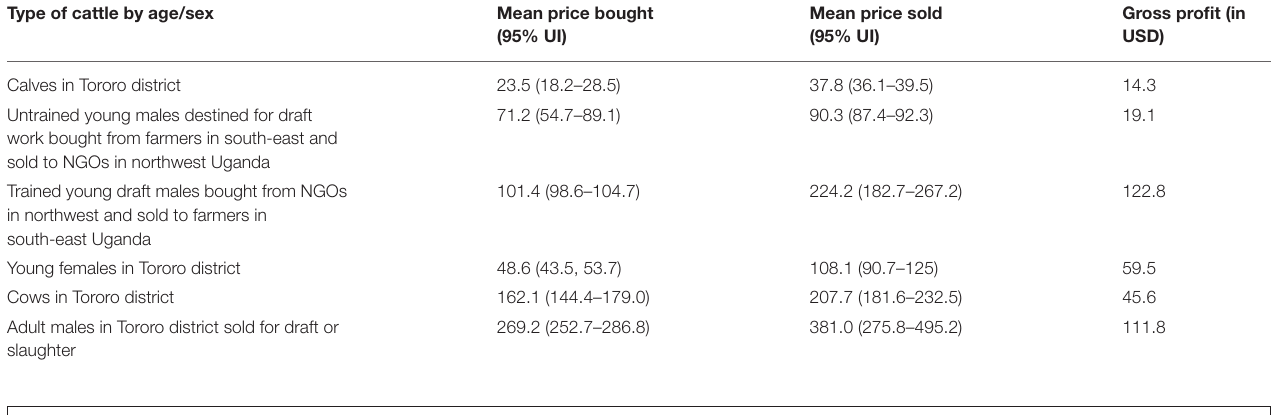
TABLE 3 | Price of cattle in the livestock markets by age and sex. Type of cattle by age/sex